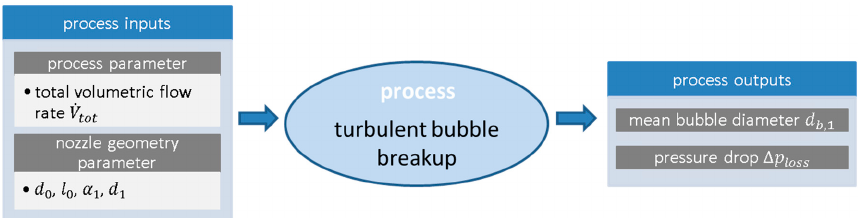
Figure 4. Process inputs and outputs in Design of Experiments set-up for turbulent bubble breakup in microchannel nozzle.